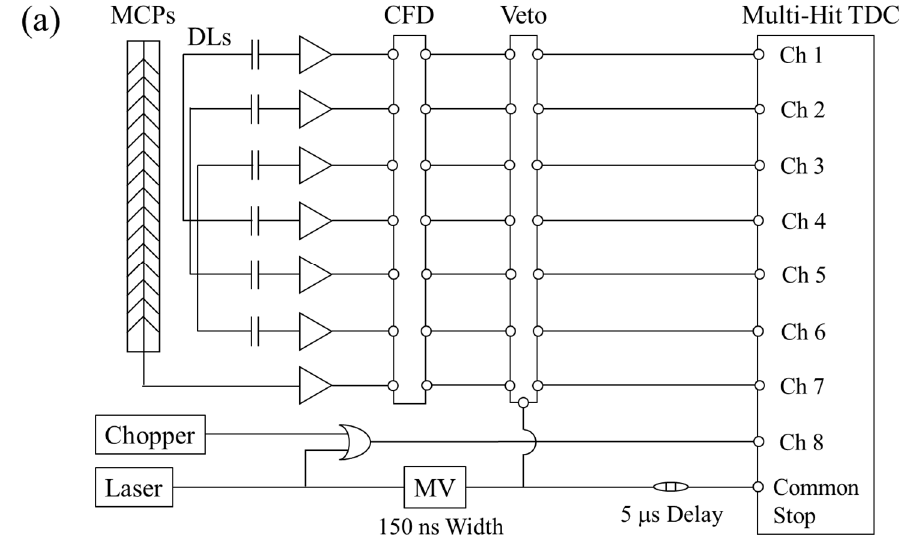
Figure 4. ( a ) Schematic diagram of a data gathering system, representing delay lines (DLs), a constant fraction discriminator (CFD), a multivibrator (MV), and a time-to-digital converter (TDC). ( b ) Timing sequence diagram of concurrent measurement of laser-on and laser-off data sets. See text for